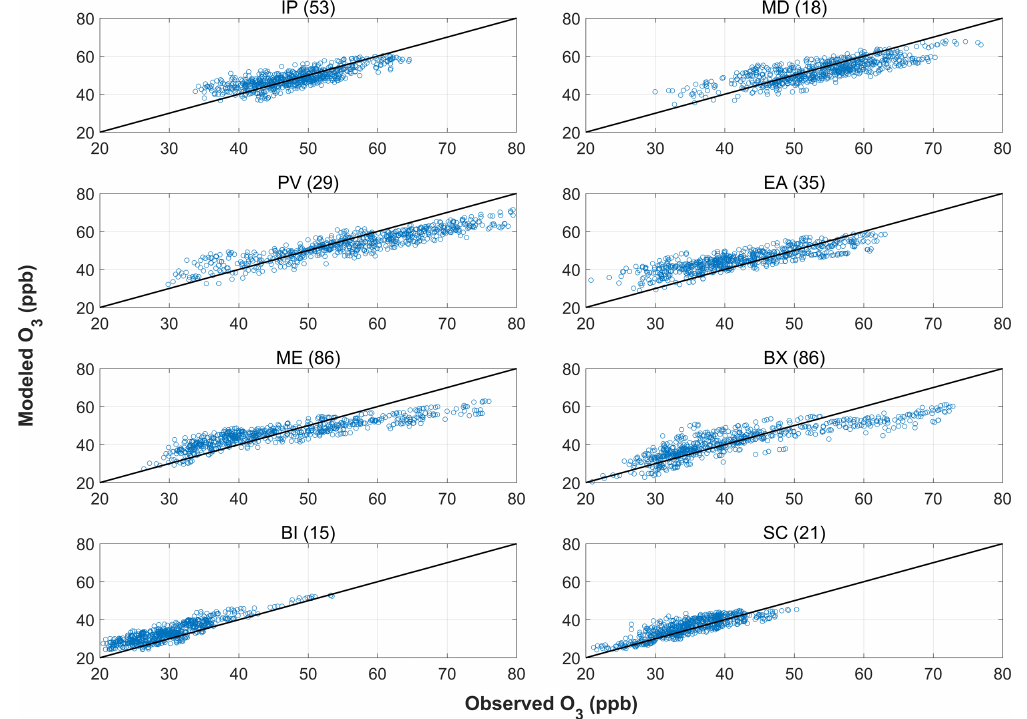
Figure 5. Scatterplots of modeled vs. observed surface afternoon (12:00–18:00UTC) mean O 3 mixing ratios in eight European regions in summer 2010. The number of stations available for each region is reported in parentheses at the top of each panel. A definition of the regions is given in Fig.